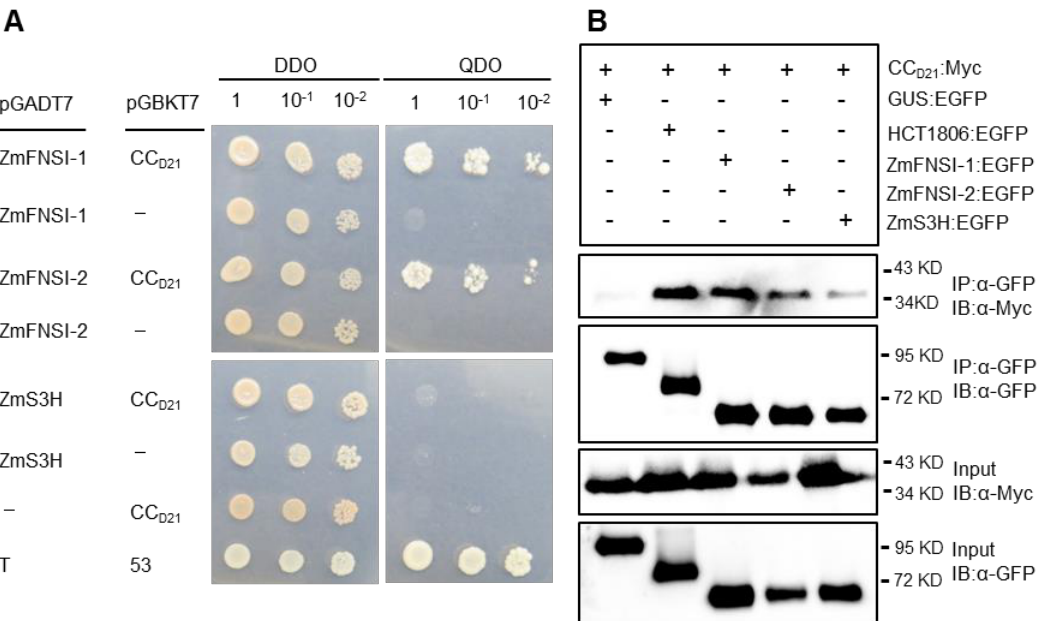
Figure 6. Investigating the interactions between CC D21 and ZmFNSIs or ZmS3H. ( A ) Investigating the interactions between CC D21 and ZmFNSIs or ZmS3H by yeast two hybridization (Y2H) assay. CC D21 was constructed into pGBKT7 and ZmFNSIs and ZmS3H were constructed into pGADT7. SV40 large T-antigen (T) and murine p53 (53) were used as the positive controls. “−” indicated empty vector. DDO: SD-Leu-Trp; QDO: SD-Leu-Trp-Ade-His. ( B ) Investigating the interactions between CC D21 and ZmFNSIs or ZmS3H by co-immunoprecipitation (Co-IP) assay. EGFP- and 4×c-Myc-tagged constructs were transiently co-expressed in N. benthamiana and samples were collected at 30 hpi for the Co-IP assay. Protein extracts were immunoprecipitated (IP) by anti-GFP (α-GFP) microbeads and detected (immunblotted; IB) by anti-GFP and anti-Myc (α-Myc) antibodies.